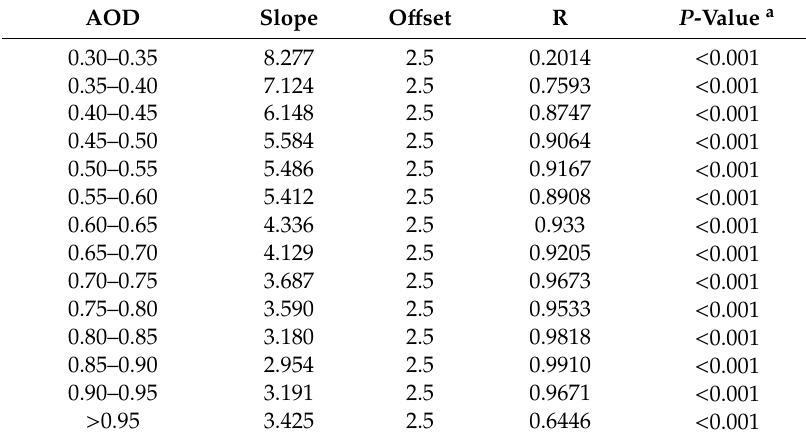
Table 3. The linear regression analysis of the relative height di ff erence ( ∆ h) of di ff erent segments with a Scale of